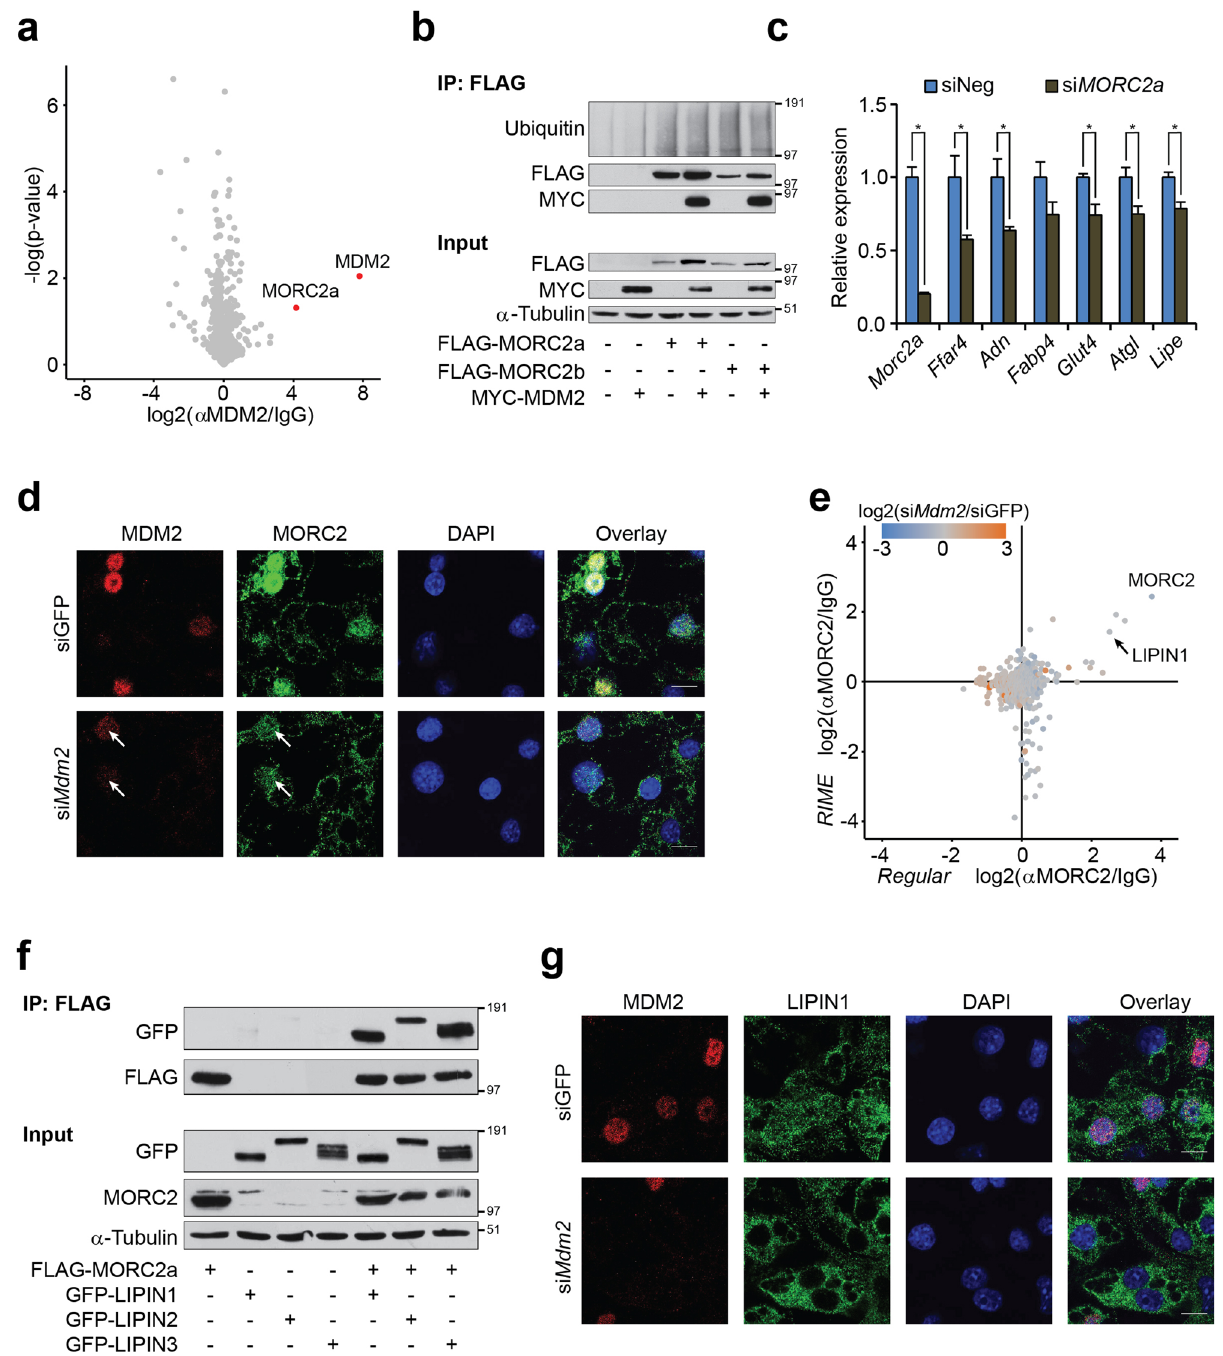
Figure 5. MDM2 is necessary for nuclear localization of MORC2 and LIPIN1. ( a ) Volcano plot of proteins enriched by all three monoclonal antibodies directed against MDM2 in lysates from 3T3-L1 adipocytes. Plot generated in Perseus software 70 . ( b ) Coimmunoprecipitation against FLAG in lysates from cells ectopically expressing FLAG-MORC2s and/or MYC-MDM2. Western blot analysis against Ubiquitin, FLAG and MYC. α-Tubulin was included as loading control. ( c ) Real-time qPCR-based quantification of Morc2a , Ffar4 , Adn , Fabp4 , Glut4 , Atgl , and Lipe in 3T3-L1 adipocytes with knockdown of MORC2a. ( d ) Localization of MDM2 and MORC2 in 3T3-L1 adipocytes with knockdown of Mdm2 as assessed by immunofluorescence. Nuclei were stained with DAPI. Grey scale bar corresponds to 10 µm. Images processed using ImageJ. ( e ) Scatterplot showing proteins enriched by MORC2 antibody with regular IP on the horizontal axis and RIME on the vertical axis. Colouring of dots refers to impact of Mdm2 knockdown with blue indicated decreased binding and orange augmented. Plots generated using Perseus software 70 . ( f ) Coimmunoprecipitation against FLAG in lysates from cells ectopically expressing FLAG-MORC2a and/or GFP-LIPIN1, − 2, or − 3. Western blot analysis against FLAG, GFP, and MORC2. α-Tubulin was included as loading control. ( g ) Localization of MDM2 and LIPIN1 in 3T3-L1 adipocytes with knockdown of MDM2 as assessed by immunofluorescence. Nuclei were stained with DAPI. Grey scale bar corresponds to 10 µm. Images processed using ImageJ. For a , p -value was calculated using Student’s t -test. For c , significance was tested using Student’s t -test, * = p -value <